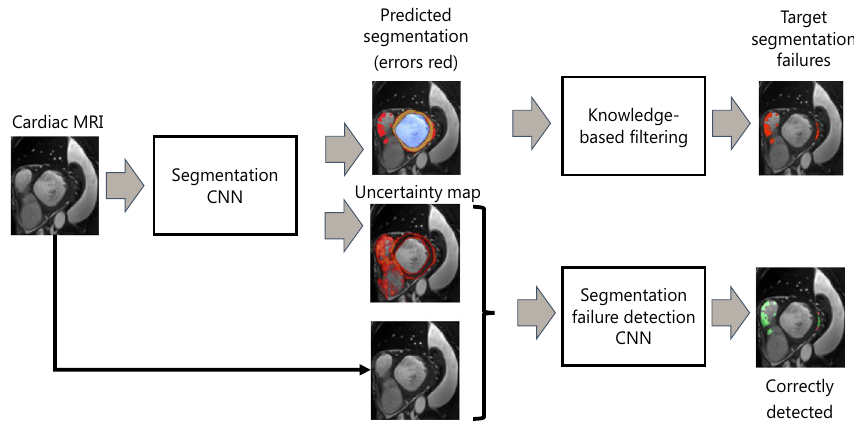
Figure 1. Overview of proposed two step approach. Step 1 (left): Automatic CNN segmentation of CMR images combined with assessment of segmentation uncertainties. Step 2 (right): Differentiate tolerated errors from segmentation failures (to be detected) using distance transform maps based on reference segmentations. Detection of image regions containing segmentation failures using CNN which takes CMR images and segmentation uncertainties as input. Manual corrected segmentation failures (green) based on detected image